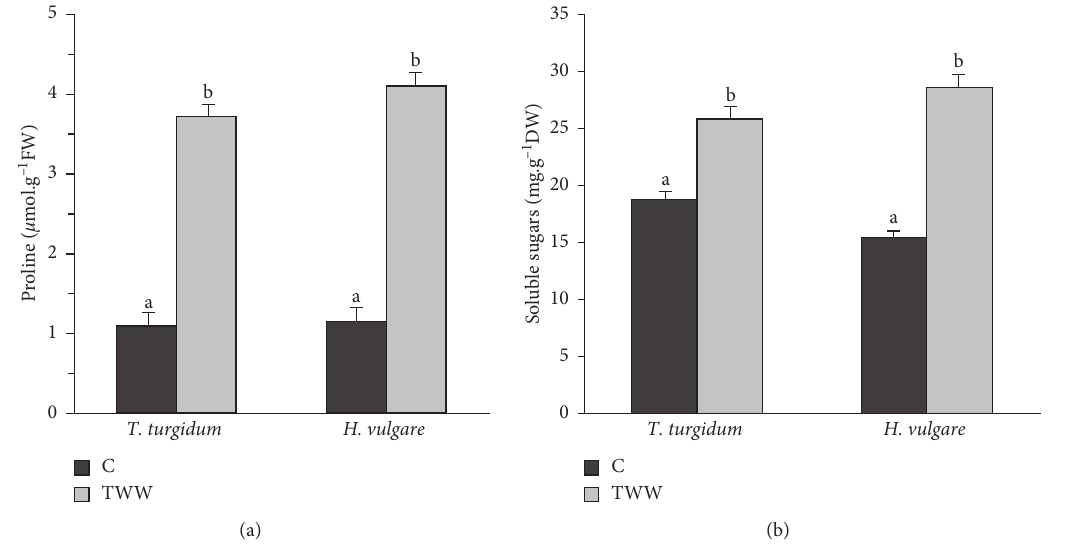
Figure 3: Proline and soluble sugars of T. turgidum and H. vulgare leaves cultured in control soils and wastewater irrigated soils. Means of four replicates. Bars marked with the same letter are not significantly different at p < 0 . 05.